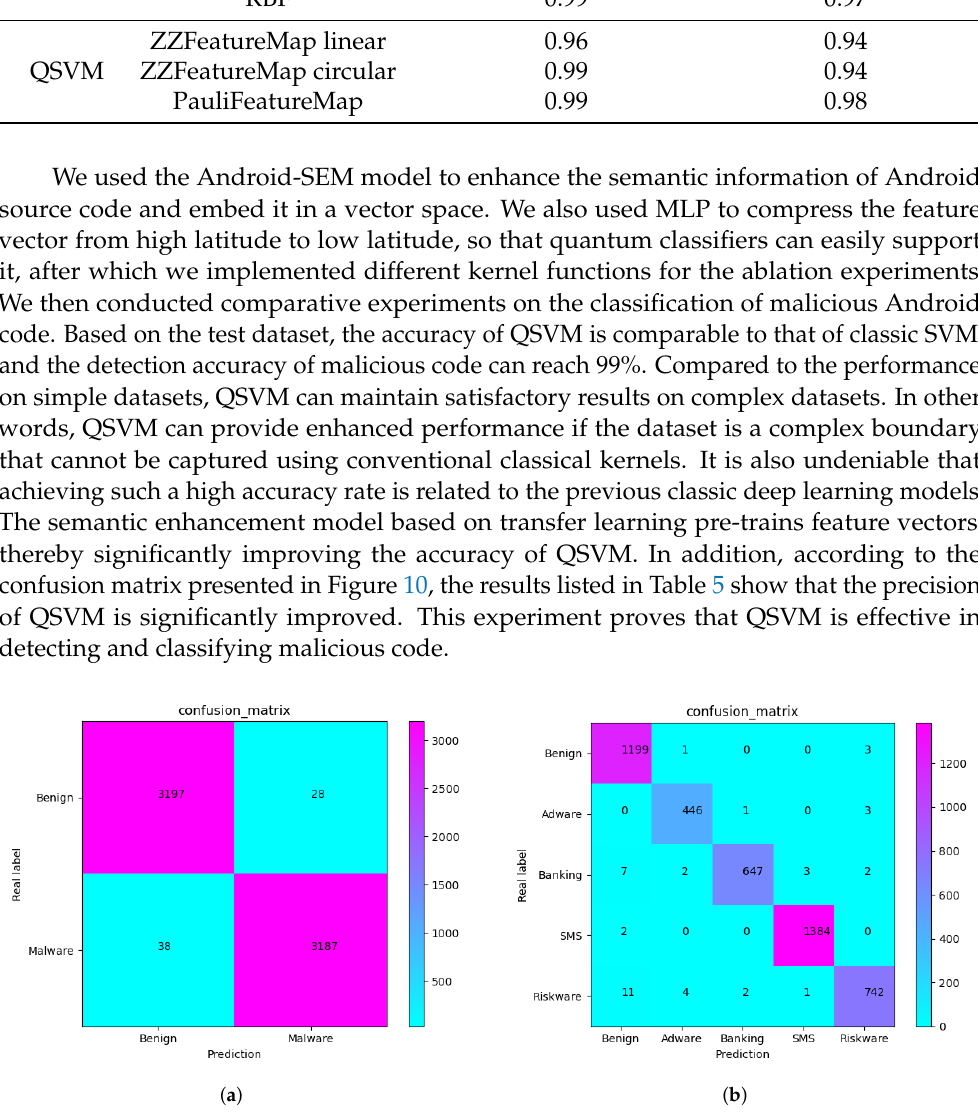
Figure 10. Quantum classifier confusion matrix: ( a ) 2-category classification; ( b ) 5-category